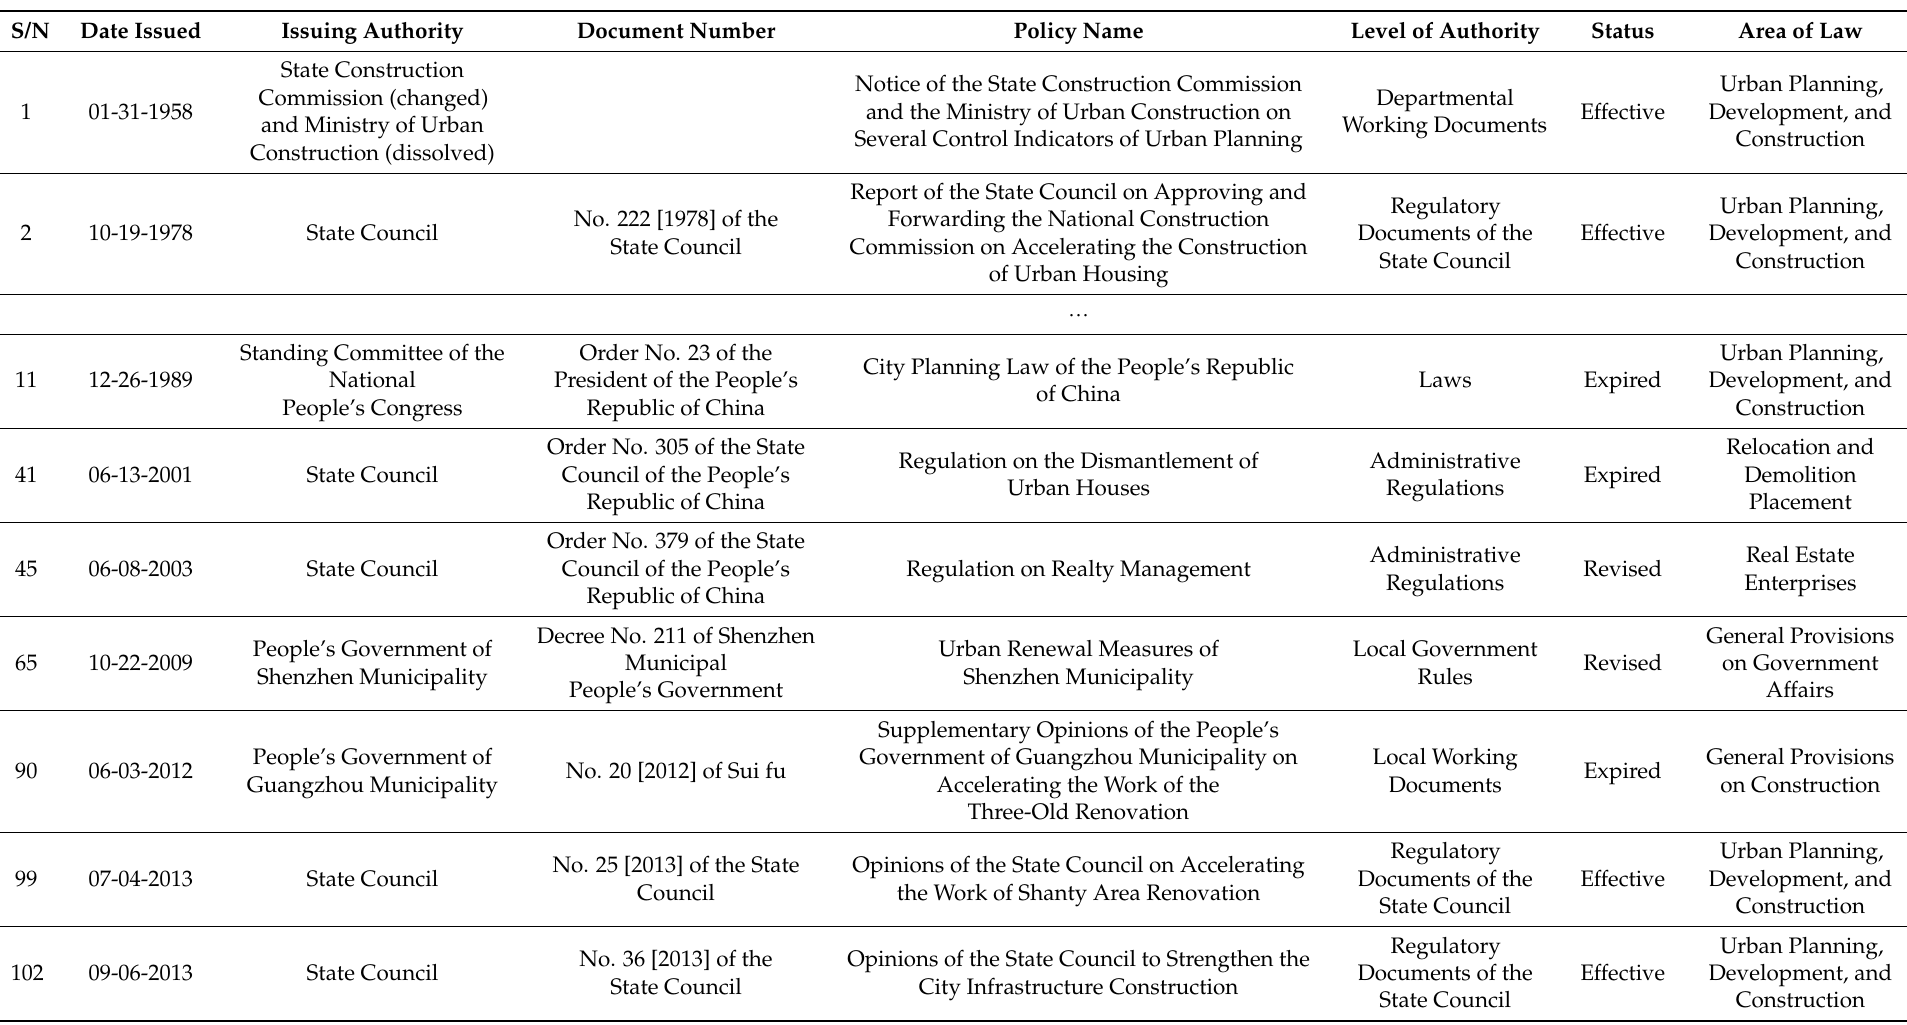
Table 2. A text database of urban renewal policy in